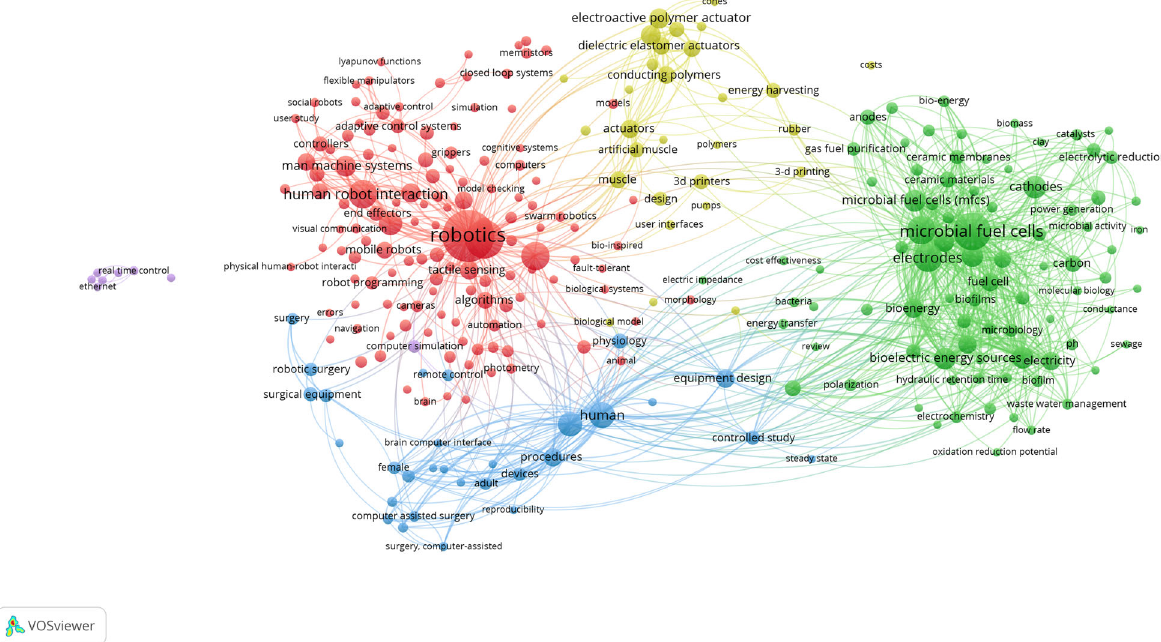
Fig. 5 Bibliometric research pro fi le illustrating the most prominent keywords found in BRL publications indexed in Scopus (644 publications; 2004 – 2020). Nodes represent 1000 tops author keywords with co-occurrence ≥ 2; keywords were found in individual articles and the size of the node indicates relative prominence of the keywords in the corpus. Links represent co-occurrence relations between keywords in individual